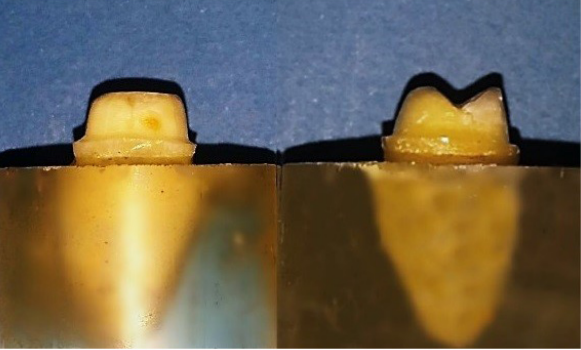
Figure 1. Flat occlusal preparation design (left) and two planes occlusal preparation design (right).